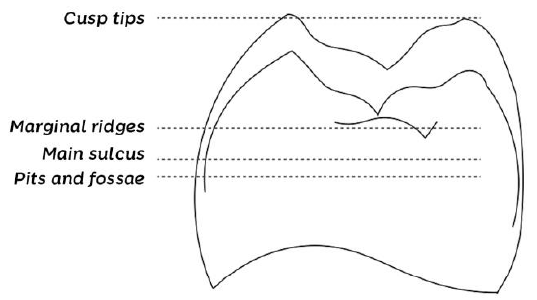
Figure 2. Four occlusal levels that must be considered when preparing posterior restorations: cusp tips, marginal ridges, main sulcus, and pits and fossae. Failure to respect this height relationship of the anatomical structures may necessitate extensive occlusal adjustment at the end of the restoration.